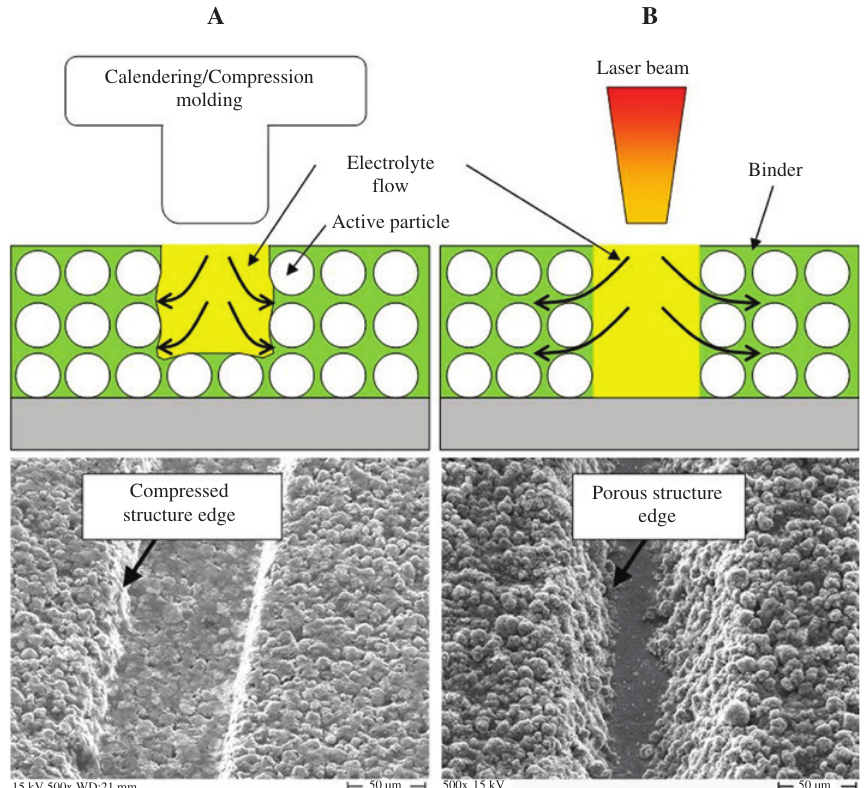
Figure 24: Capillary structures produced in NMC by embossing (A) in comparison to micro-channels generated by laser ablation